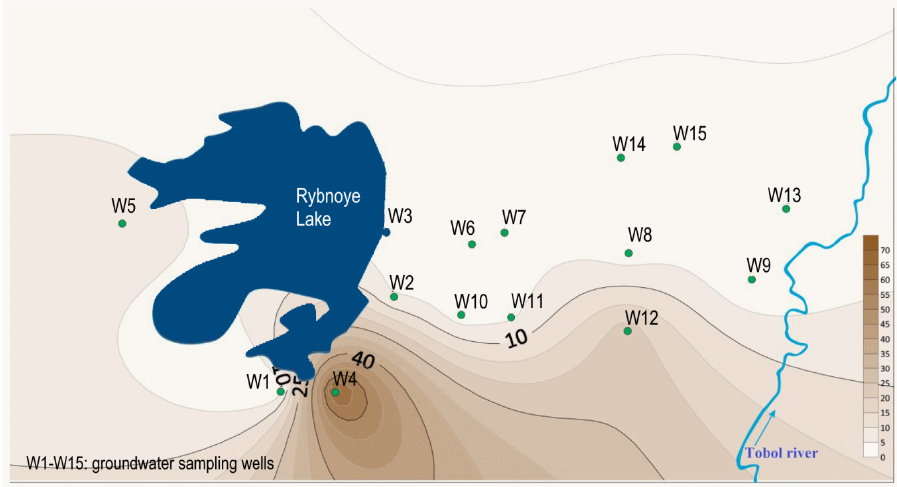
Figure 6. Isolines of nitrates (N ‐ NO 3 ) in the groundwater in the study area (mg/dm 3 ). Table 4. Average values of the selected quality parameters of groundwater and the Tobol River. Sampling